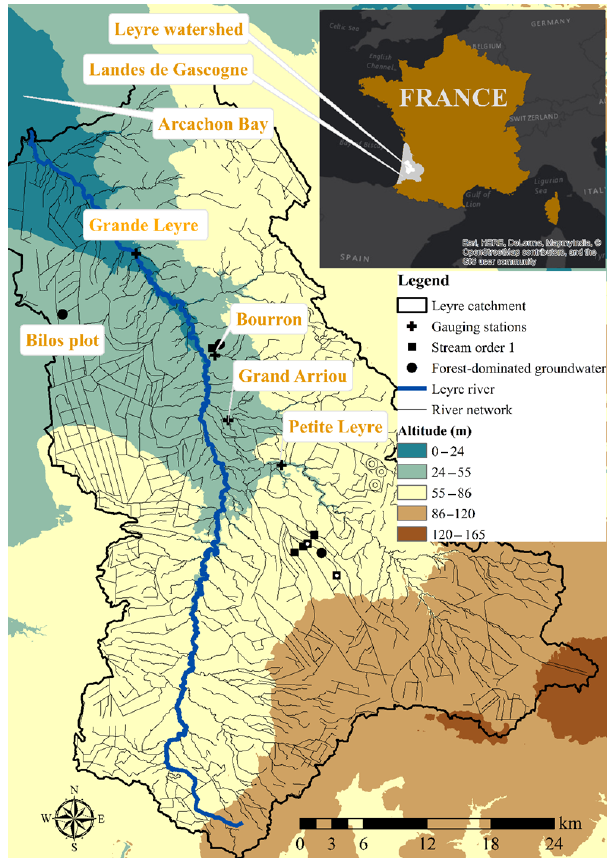
Figure 1. Map of the Leyre watershed with topography showing the location of the gauging stations (the Grande Leyre, the Petite Leyre, the Grand Arriou and the Bourron rivers), the Bilos site, and the other sampled piezometers and first-order streams. The rain gauge and eddy tower are located at the Bilos plot. White circles indicate the first-order streams where additional discharge measure- ments were made in April 2014 and February